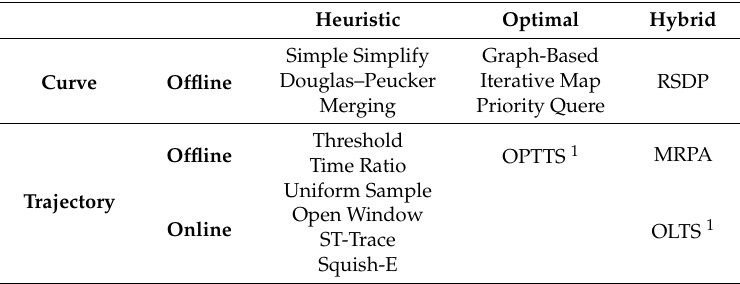
Table 1. Classification of TS